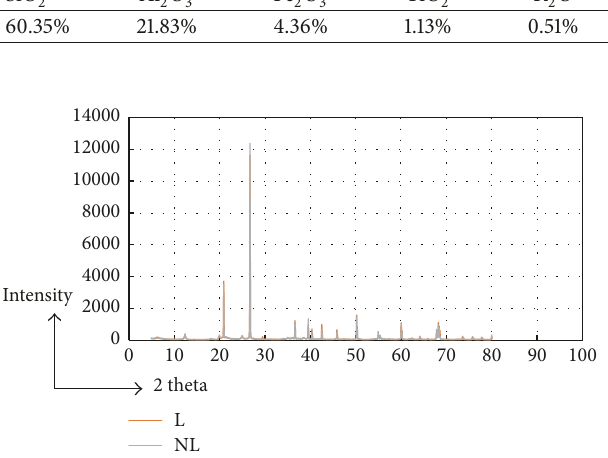
Figure 2: Relation graph between intensity and 2 theta for lime and nanolime